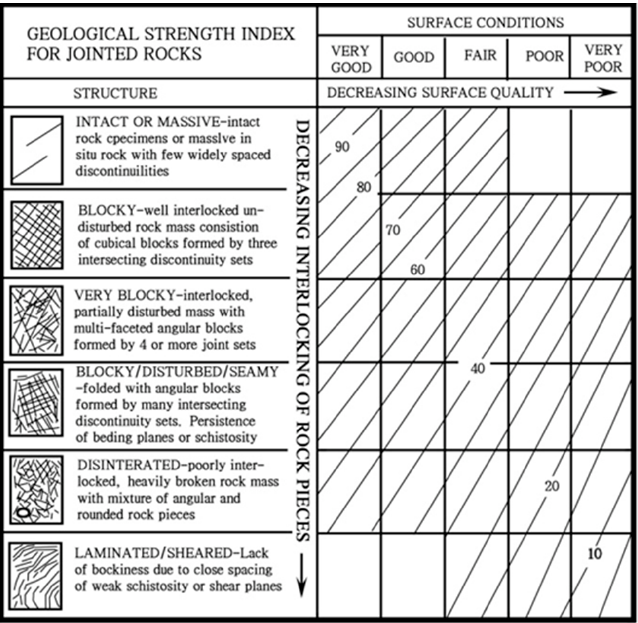
Figure 1. Chart for determining the geological strength index (GSI) of jointed rock mass [21].